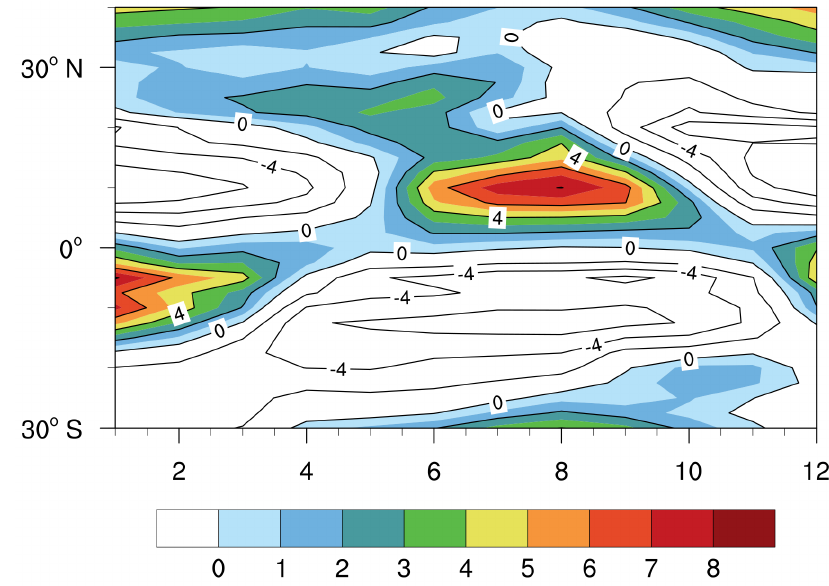
Figure 1. Latitude–time cross-section of 850 hPa zonal wind (2011–2020) mean along 110 ◦ –120 ◦ E. Figure 1. Latitude − time cross-section of 850 hPa zonal wind (2011 − 2020) mean along 110°–120° E. The shaded area denotes positive zonal winds (unit: m s − 1 ). The x -axis represents months from The shaded area denotes positive zonal winds (unit: m s −1 ). The X − axis represents months from Jan- January to uary to December.